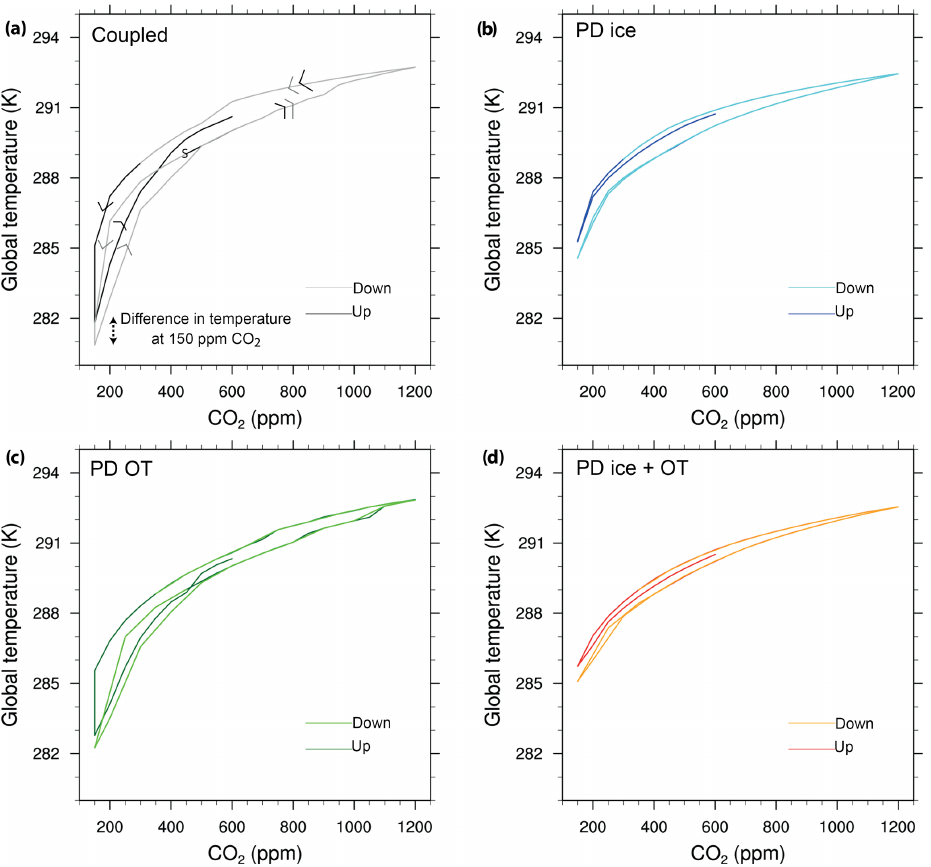
Figure 3. Relation between CO 2 and global temperature in the equilibrium runs. In panel (a) , the fully coupled model output is shown. The starting point of the simulation at 450ppmCO 2 is marked by an S, and the consequent evolution for both runs is marked by coloured arrows. The black line shows the up run in which CO 2 is increased first, and the grey line shows the down run in which CO 2 is decreased first. At high CO 2 levels, the black line is overlaid by the grey line. (b) The output with uncoupled ice (blue and cyan), (c) with uncoupled ocean overturning strength (dark green and green), and (d) with both these factors uncoupled (red and orange). The darker colours (blue, dark green, red) show the up runs, and the lighter colours (cyan, green, orange) show the down runs. The starting point and evolution are the same as in panel (a)